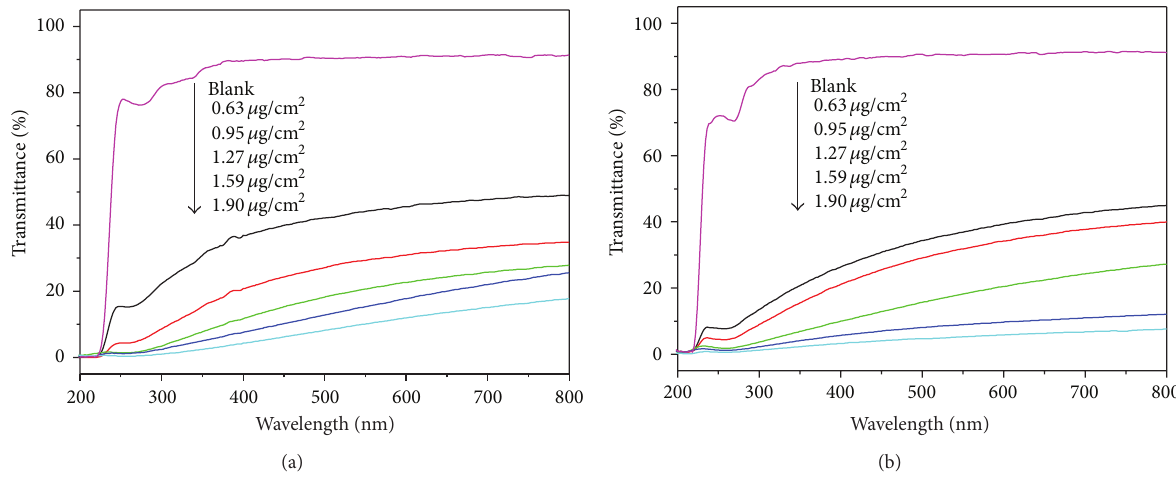
Figure 5: (a) UV-Vis light transmitted spectra of (a) RGO@PVA and (b) RGO@PDMS composite